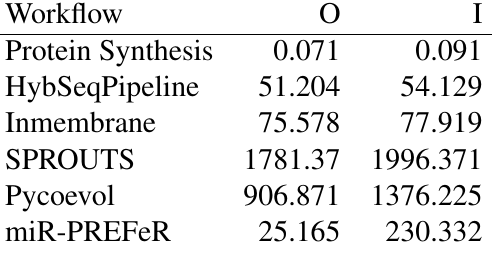
Table 3: Performance (in seconds) of the execution of the original workflow (O) vs. its instru- mented version (I).